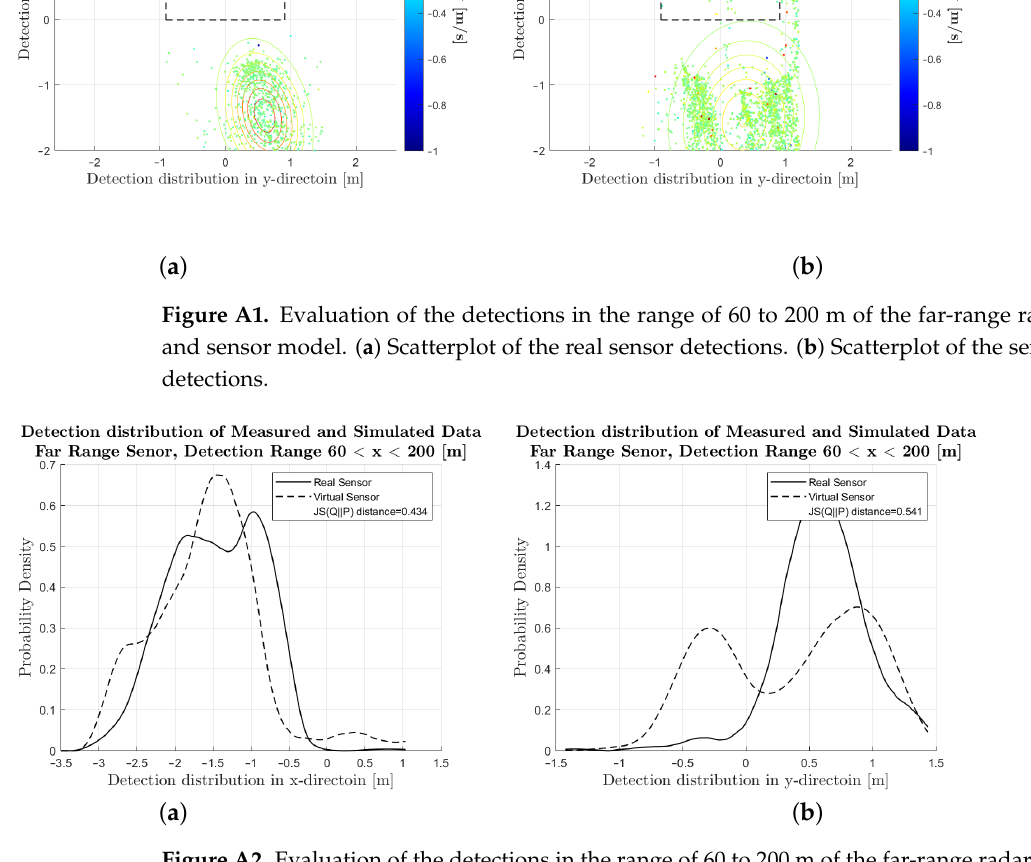
Figure A2. Evaluation of the detections in the range of 60 to 200 m of the far-range radar sensor and sensor model. ( a ) PDF of the deviation in the x -direction from P ref ( x , y ) of the real sensor and sensor model. ( b ) PDF of the deviation in the y -direction from P ref ( x , y ) of the real sensor and sensor